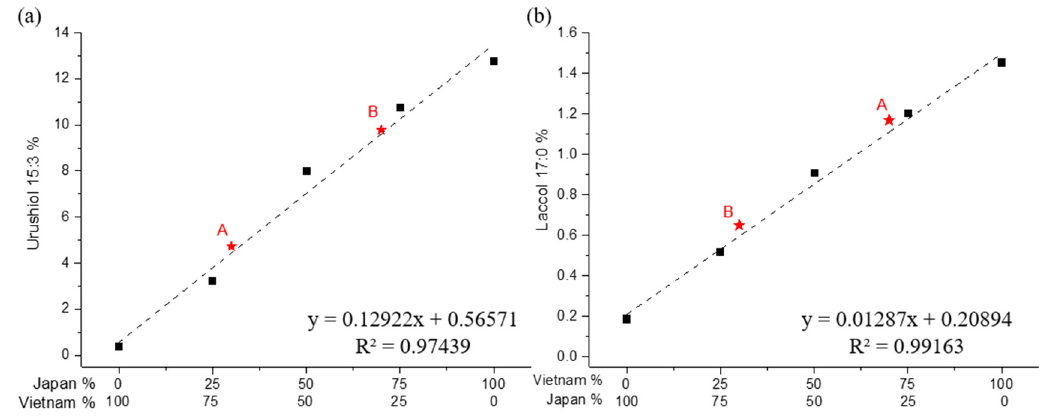
Figure 4. Calibration curves of the compositional ratios of blended Japanese and Vietnamese lacquer films in accordance with the detection peaks using Py–GC/MS: ( a ) urushiol peak (U1); ( b ) laccol peak (L1).